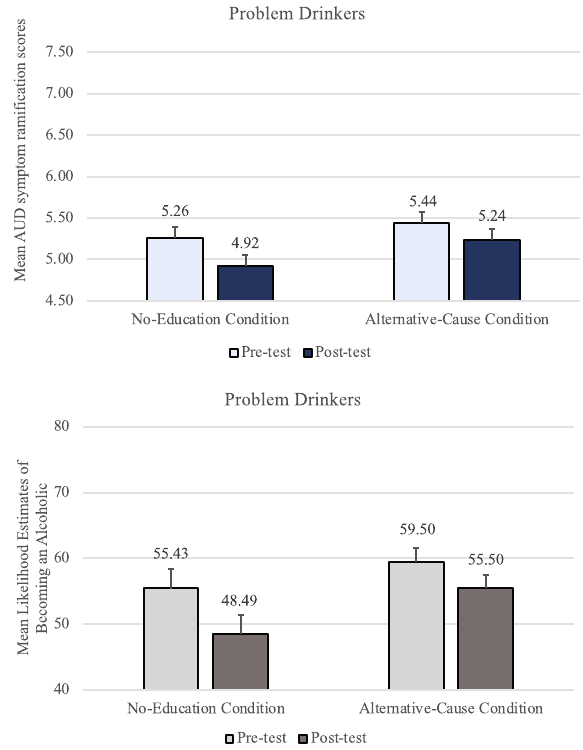
Figure 3. Problem-drinkers’ mean AUD symptom ramification scores and mean likelihood estimates of becoming an alcoholic in Study 1, by condition at pre-test and post-test. Error bars represent SEM pairedDiff